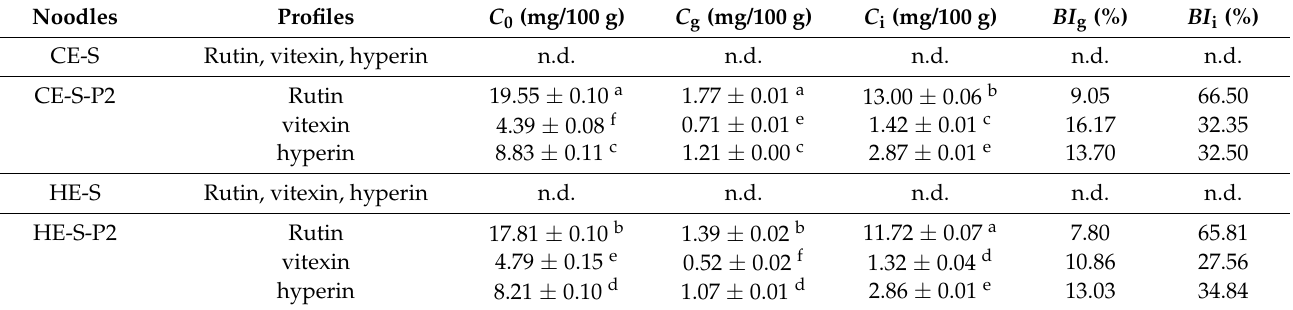
Table 2. Bioaccessibility index of main phenolic profiles in digestion liquids of cold and hot extruded noodles during simulated in vitro gastrointestinal